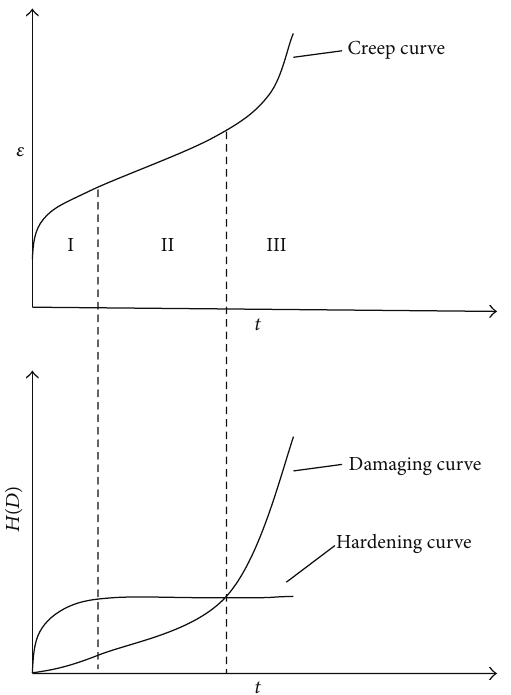
Figure 1: Sketch of creep, damage, and hardening curves.